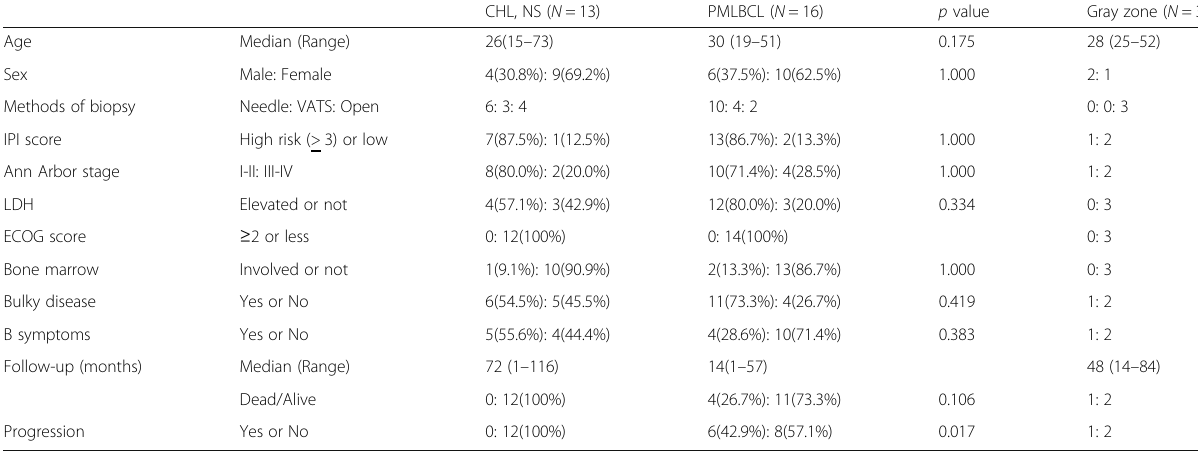
Table 1 Clinical profile of patients with B-cell lymphoma of the mediastinum